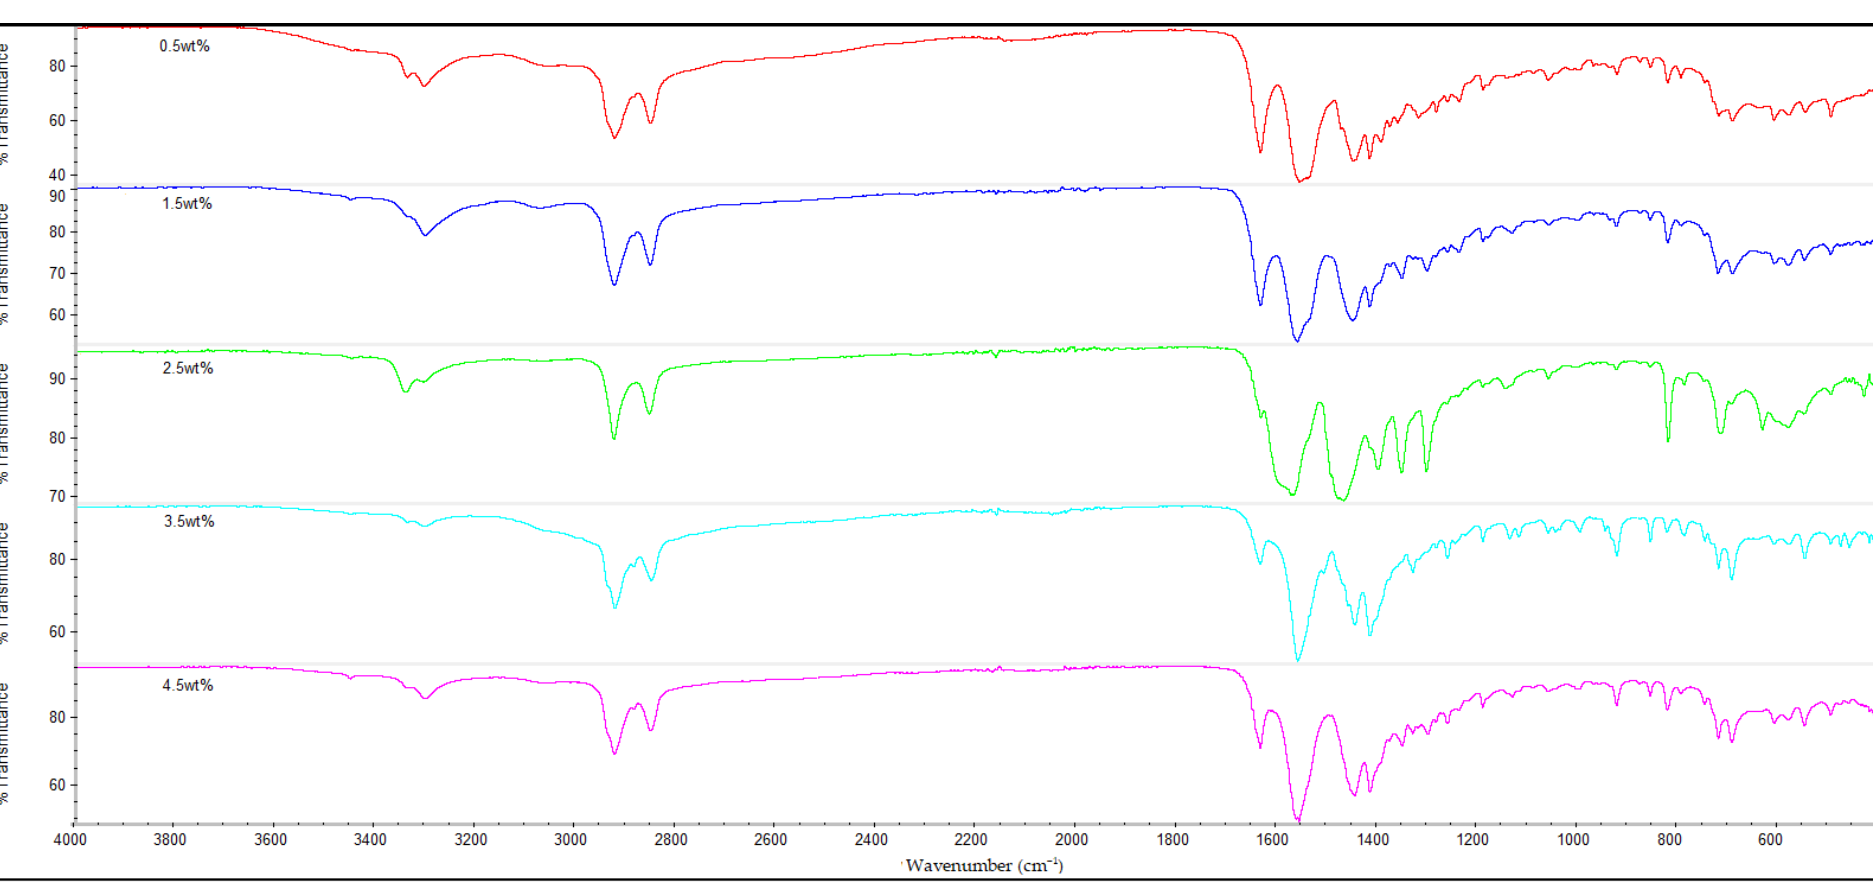
Figure 13. FTIR Spectra for Nylon 610 Nanocomposites with Untreated Graphite Nanosheets.